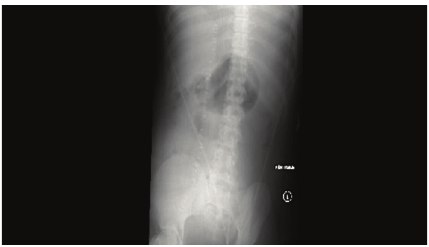
Figure 4: Single supine film of the abdomen at 5 h after surgery demonstrates a left upper quadrant opacity. no bullet is seen.